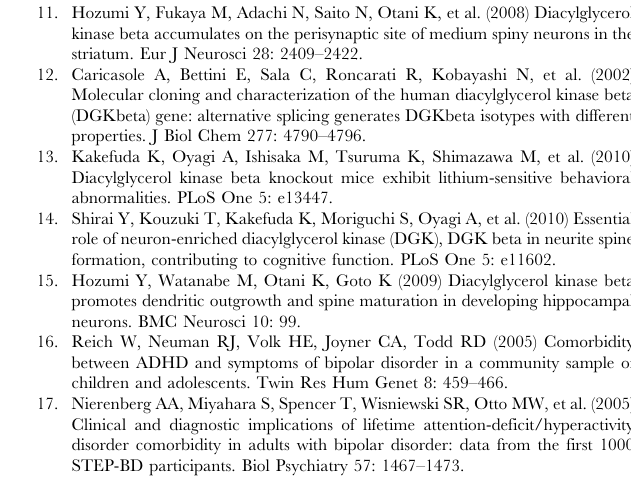
Figure S2 Western blot analysis of the phosphorylation levels of ERK1/2 in the prefrontal cortex and hippo- campus. Phosphorylated and total ERK1/2 levels in the prefrontal cortex were measured by Western blot analysis. Representative immunoblots showing the expression levels of phosphorylated ERK1/2 (p-ERK1/2) and total ERK1/2 (t- ERK1/2) in the prefrontal cortex of WT and DGK b KO mice 5 min after (A) and 40 min (B) after drug treatment. Represen- tative immunoblots showing the expression levels of phosphory- lated ERK1/2 (p-ERK1/2) and total ERK1/2 (t-ERK1/2) in the hippocampus of WT and DGK b KO mice 5 min after (C) and 40 min (D) after drug treatment. Values are expressed as the mean 6 S.E.M. (n=